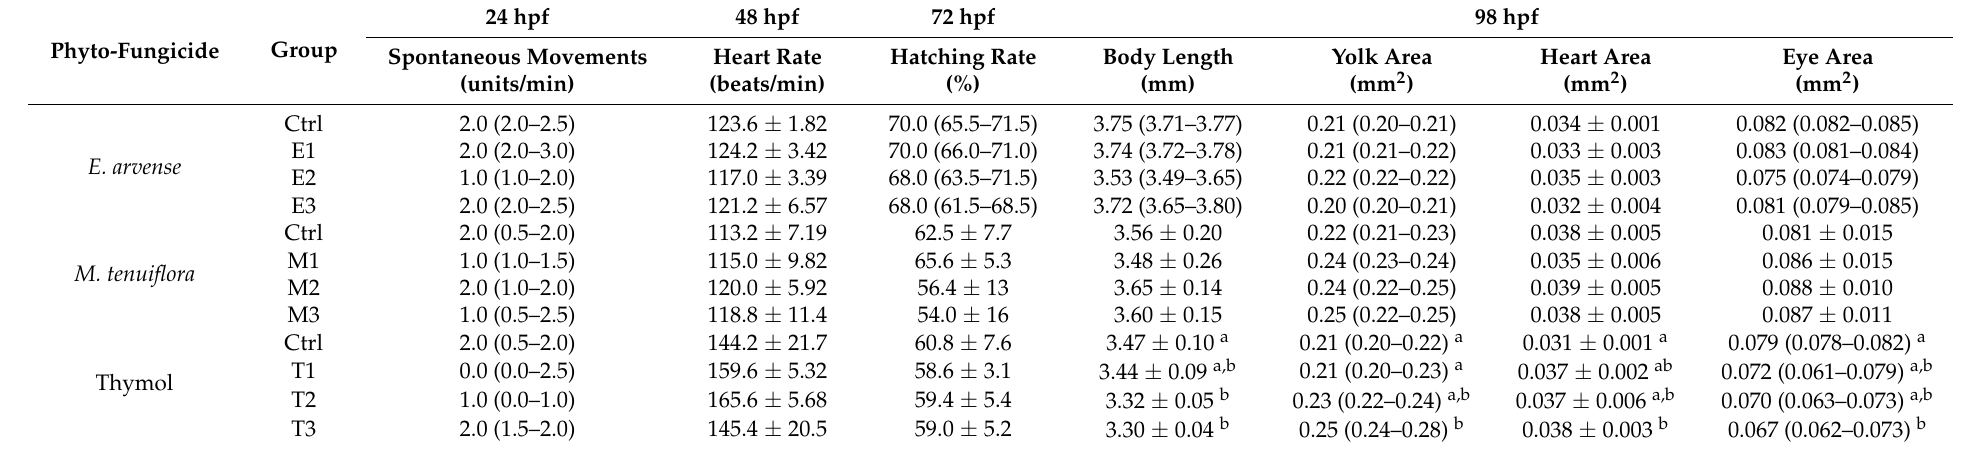
Table 1. Effects of the different exposures on spontaneous movements, heart rate and hatching rate in zebrafish embryos. Morphometric parameters were recorded in zebrafish eleutheroembryo at 98